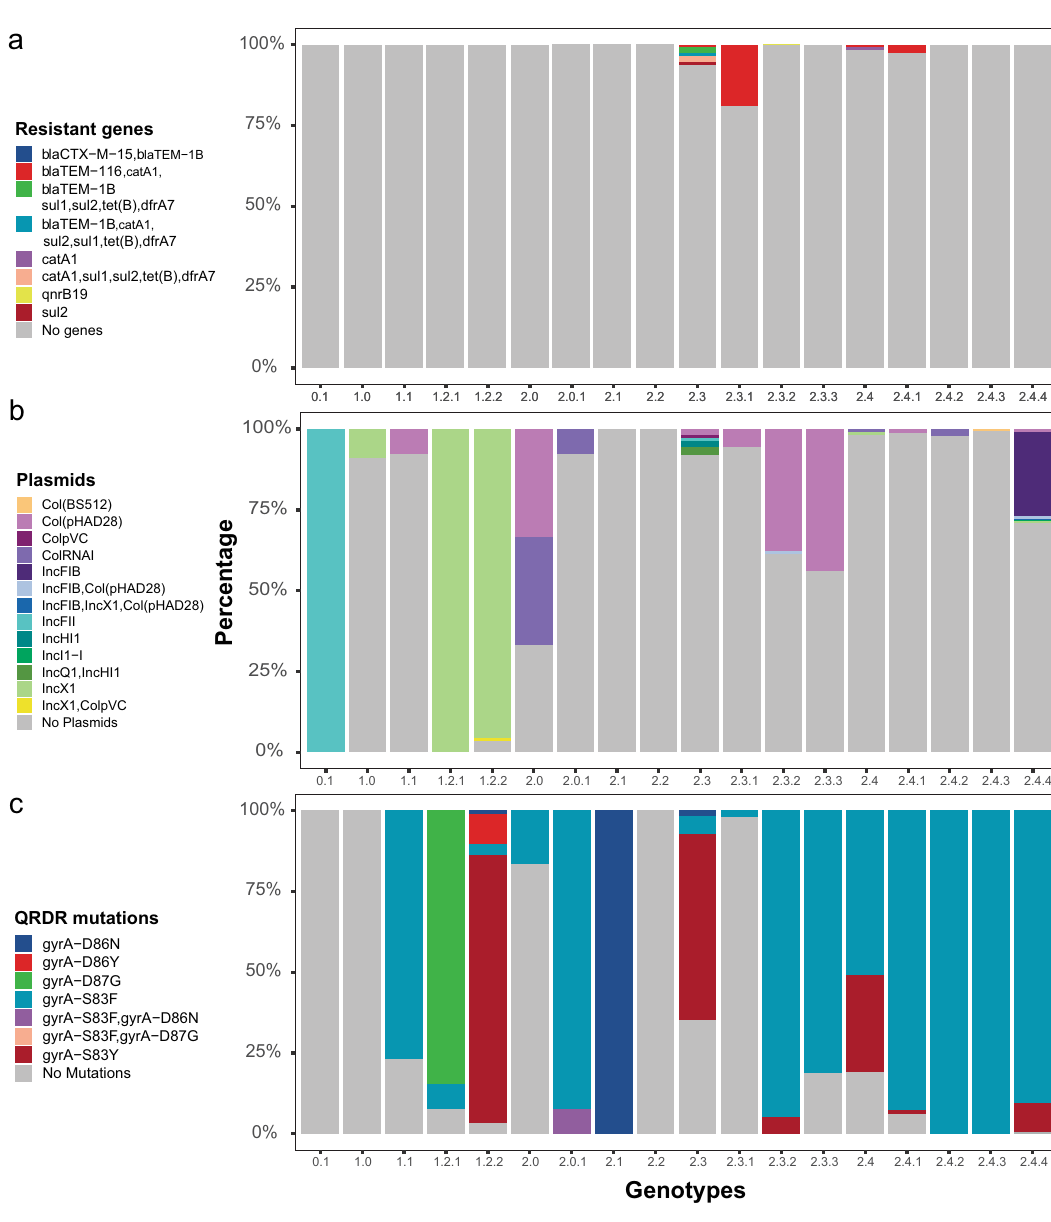
and ( c ) Quinolone resistance determining region (QRDR) mutations present Salmonella Paratyphi A is